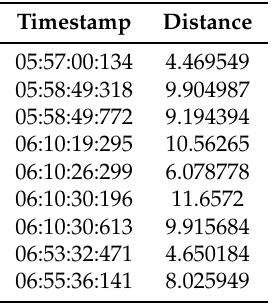
Table 7. Sample of the infrared dataset generated by our example.